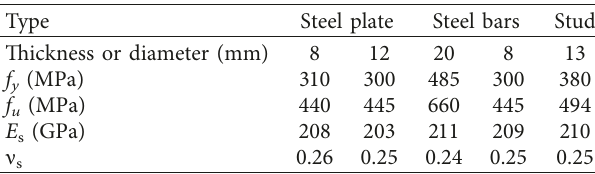
Table 2: Mechanical properties of steel.